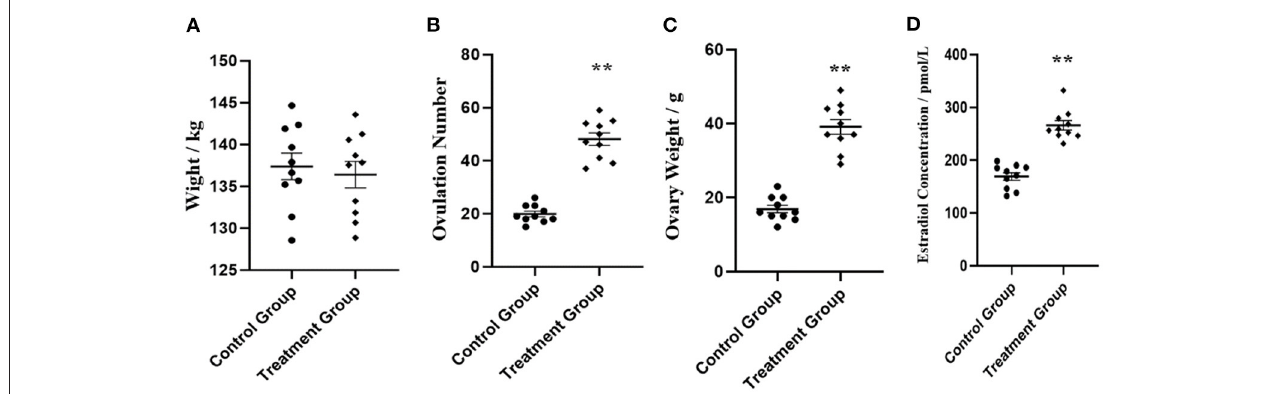
FIGURE 1 | Phenotypic data analysis of experiment gilts between control group and rpFSH treatment group ( n = 10). (A) Live weight analysis. (B) Ovulation number analysis of bilateral ovaries. (C) Ovary weight analysis of bilateral ovaries. (D) Estradiol concentration analysis in serum. ** P < 0.01.